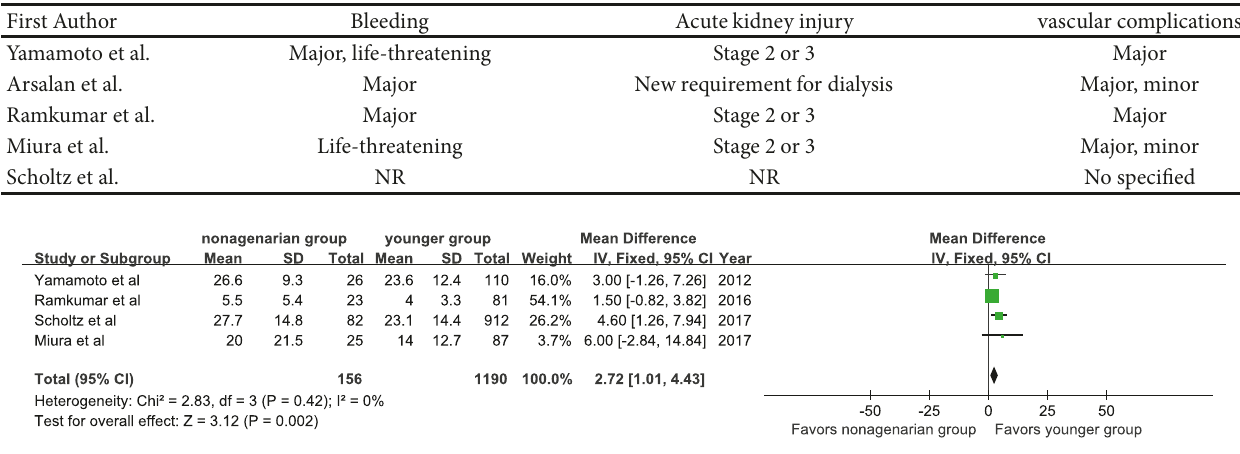
Figure 3: Forest plot of pooled analysis comparing logistic European System for Cardiac Operative Risk Evaluation of nonagenarians versus younger patients.